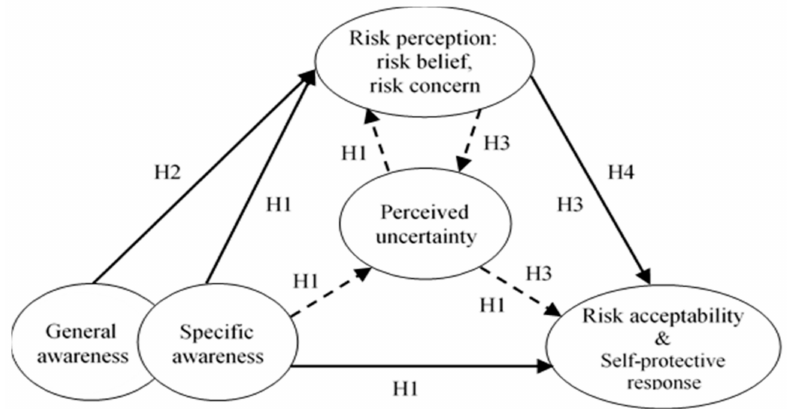
Figure 1. Hypothesized concept